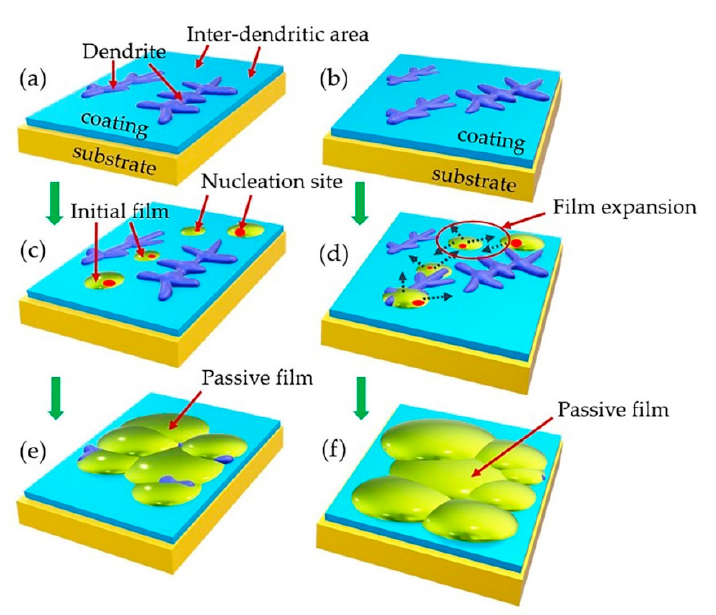
Figure 15. Element distribution in the dendrites and inter-dendritic areas in the 55NiTi + 5Ni coating: ( a ) EDS line scanning results; ( b ) EDS region scanning results.